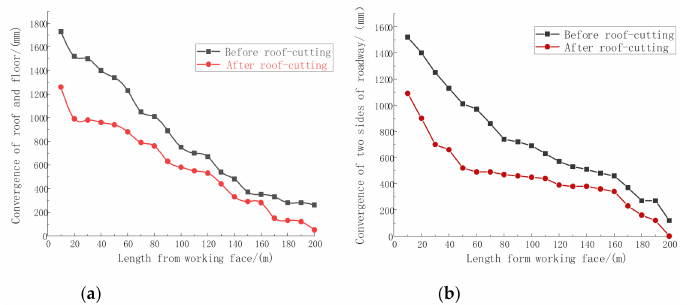
Figure 15. Comparison of roadway deformation before and after roof cutting. ( a ) Convergence of roof and floor ( b ) Convergence of two sides of